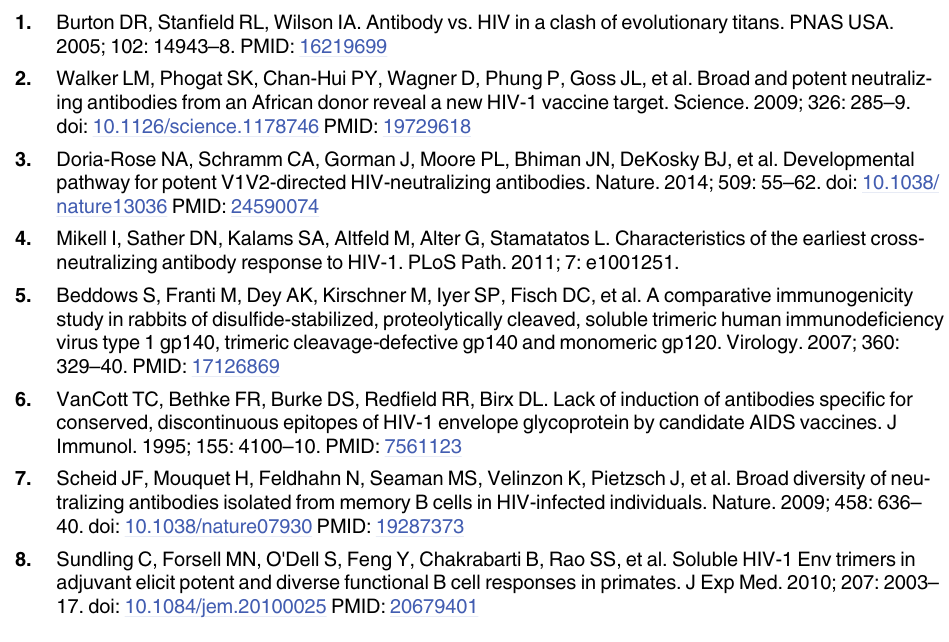
S1 Table. Analysis of Ab variable genes encoding QtAbs analyzed functionally in this study. S2 Table. Identification of critical residues involved in mAb